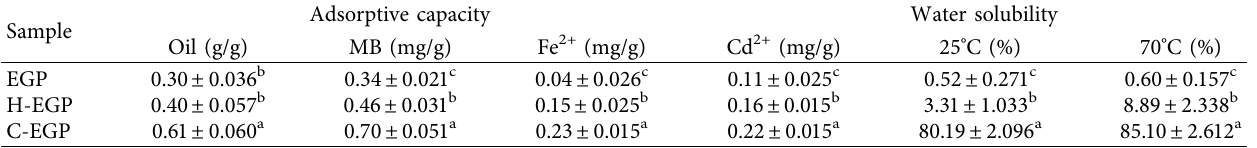
Table 3: Adsorptive capacity and water solubility of EGP and modified